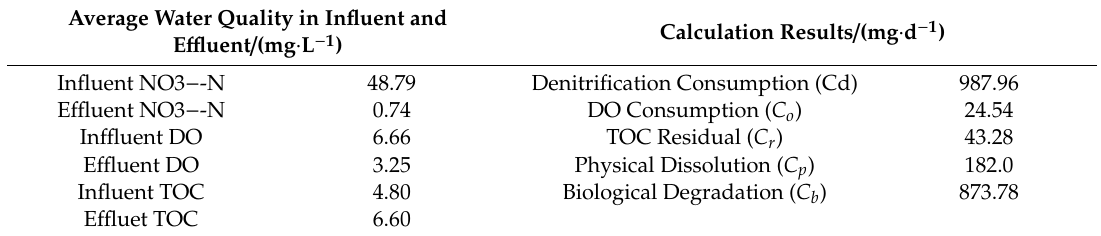
Table 2. Mass balance table of TOC in solid-phase denitrification